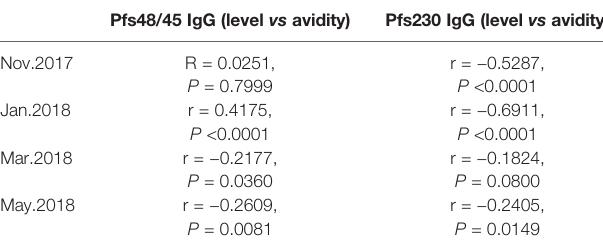
TABLE 3 | Correlation between IgG level and avidity against Pfs230, Pfs48/45. Pfs48/45 IgG (level vs